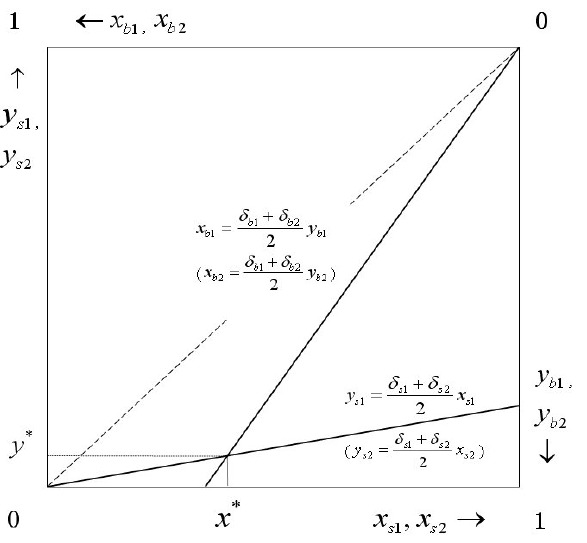
Figure 1. Perfect equilibrium ( x ∗ , y ∗ ) for the bargaining game of two sellers and two